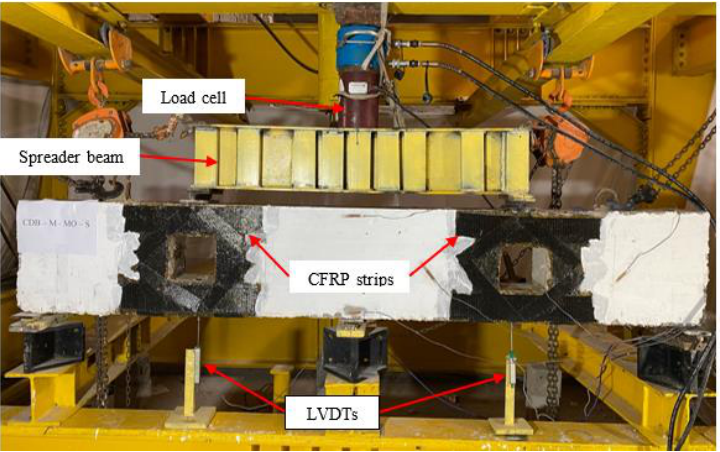
Figure 5. Test setup.